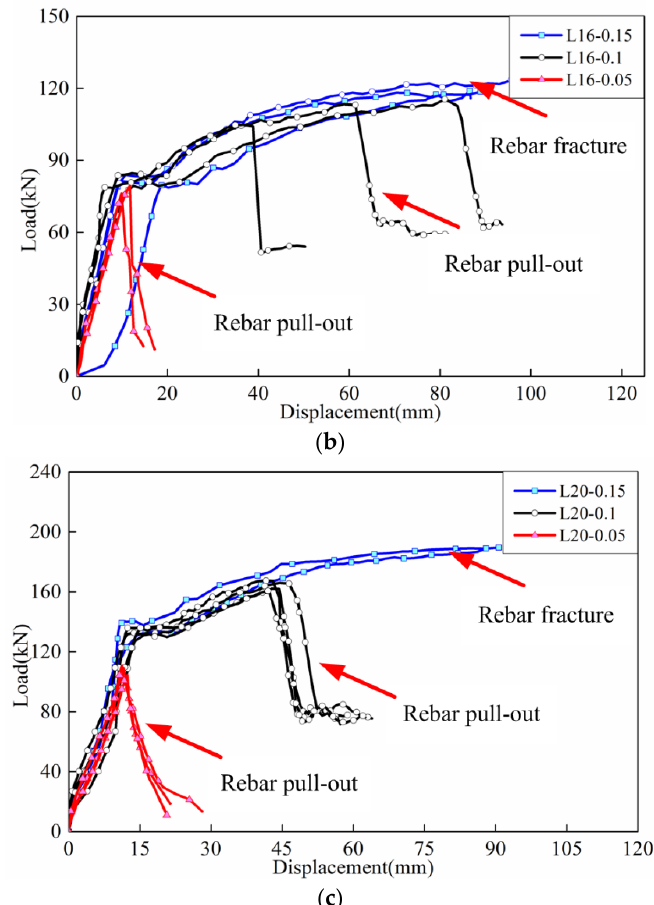
Figure 7. Load – displacement curves. ( a ) L12 ( b ) L16 ( c ) L20. Figure 7. Load–displacement curves. ( a ) L12 ( b ) L16 ( c )